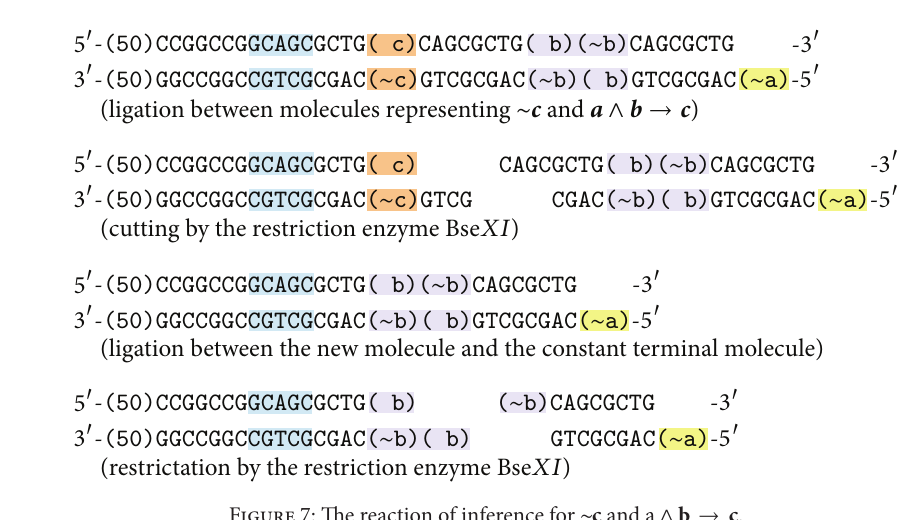
Figure 6: The reaction of inference for a , b and a ∧ b → c .